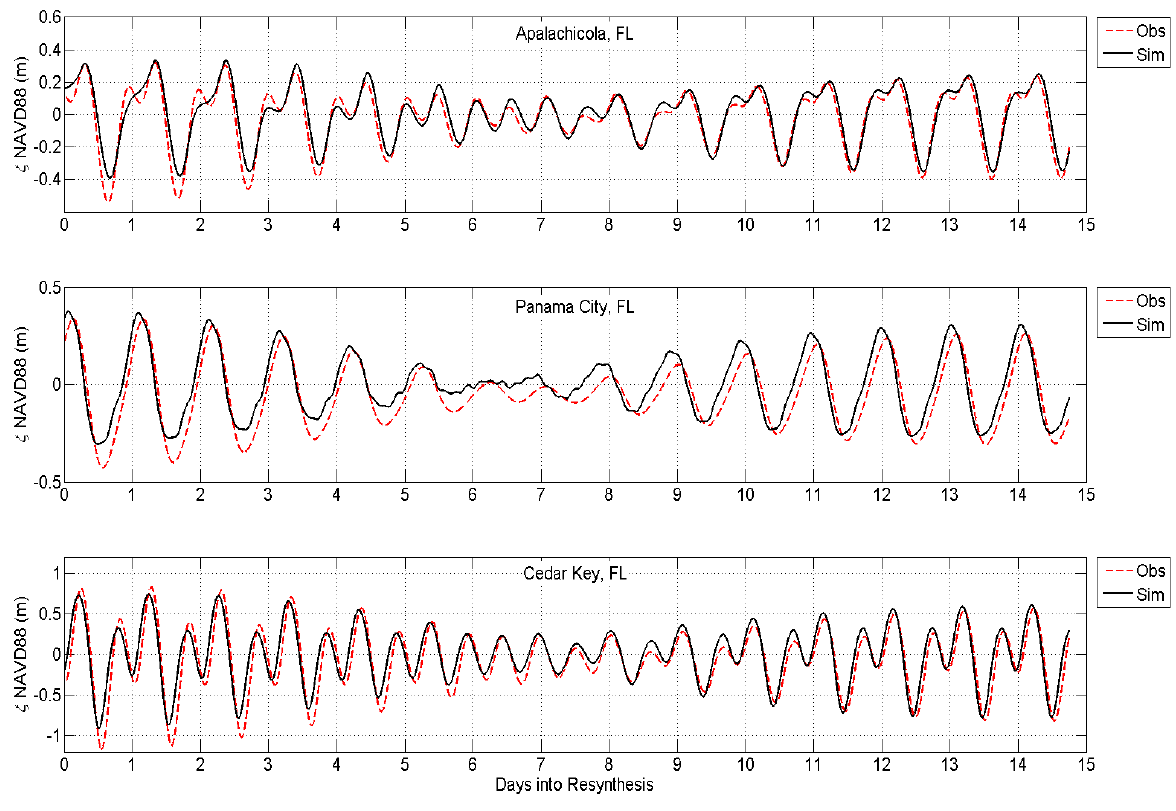
Figure 5. Comparison of predicted and observed tidal harmonic resynthesis